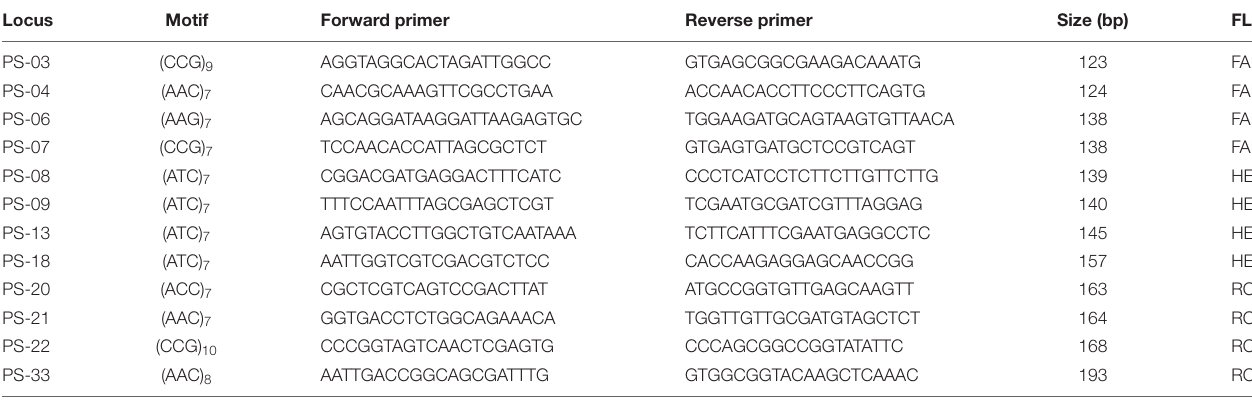
TABLE 2 | Twelve microsatellite markers developed for Phyllotreta striolata in this study. Locus